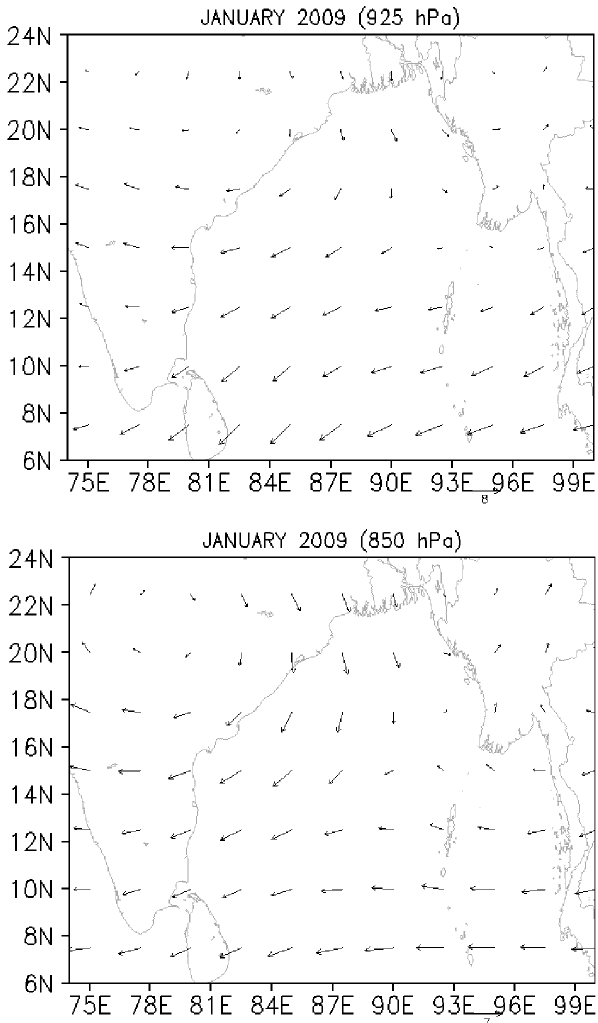
Fig. 3. NCEP/NCAR derived monthly mean (January 2009) wind patterns at pressure levels 925 (upper panel) and 850hPa (lower panel), corresponding to ∼ 770 and 1550m altitudes above ground level